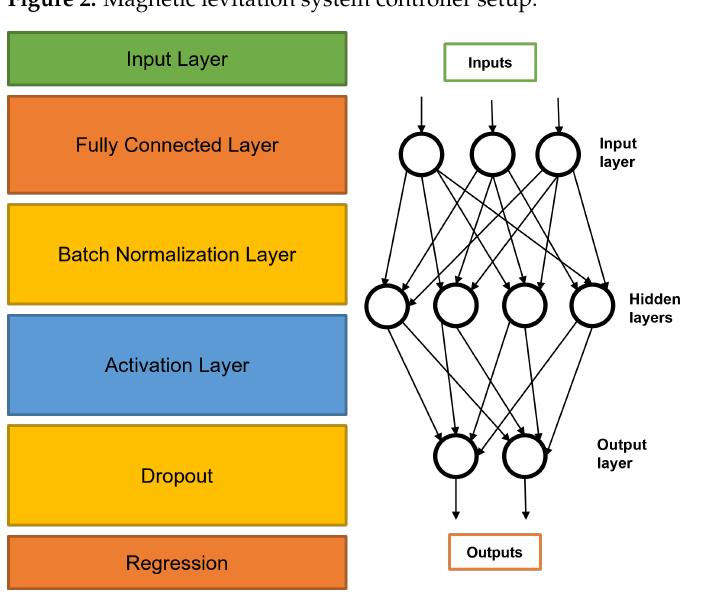
Figure 3. Deep learning